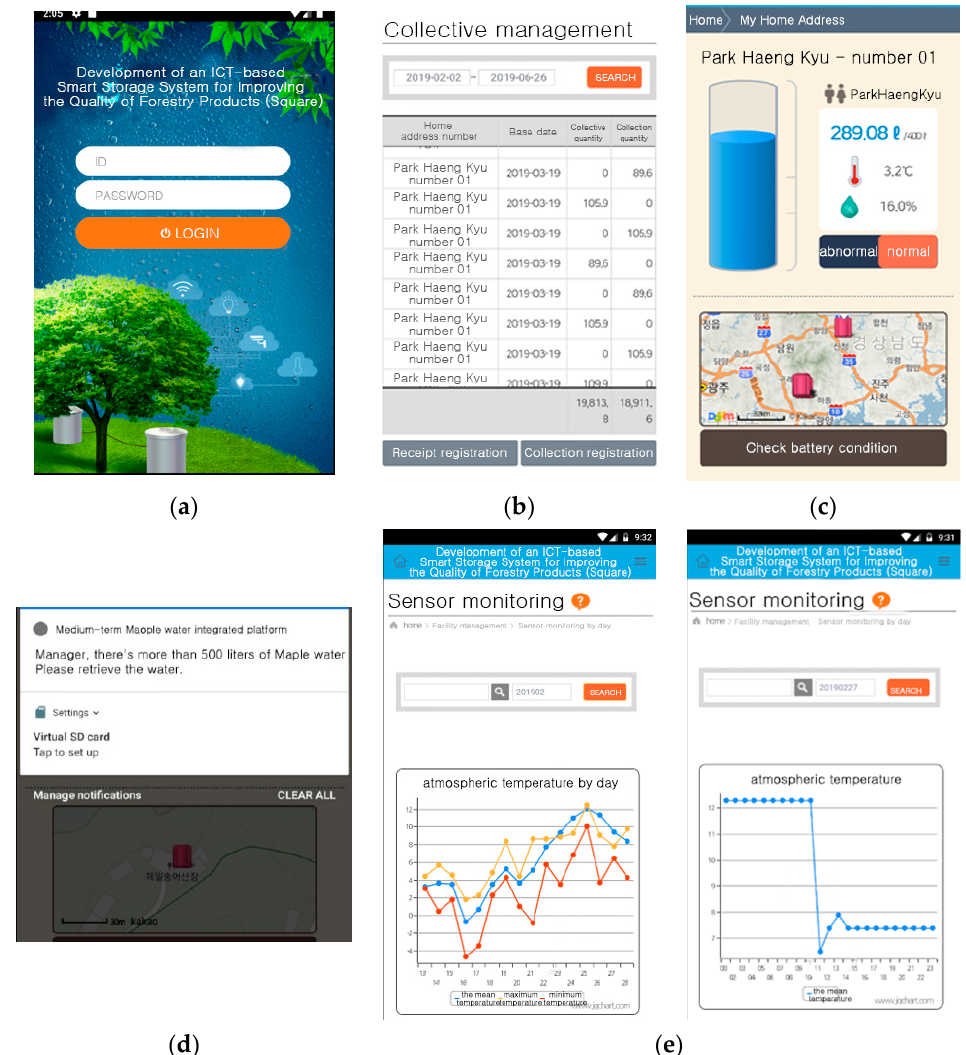
Figure 12. Monitoring UI of Acer mono sap. ( a ) main; ( b ) sap output; ( c ) farm information; ( d ) collection tank push; ( e ) sensor monitoring.